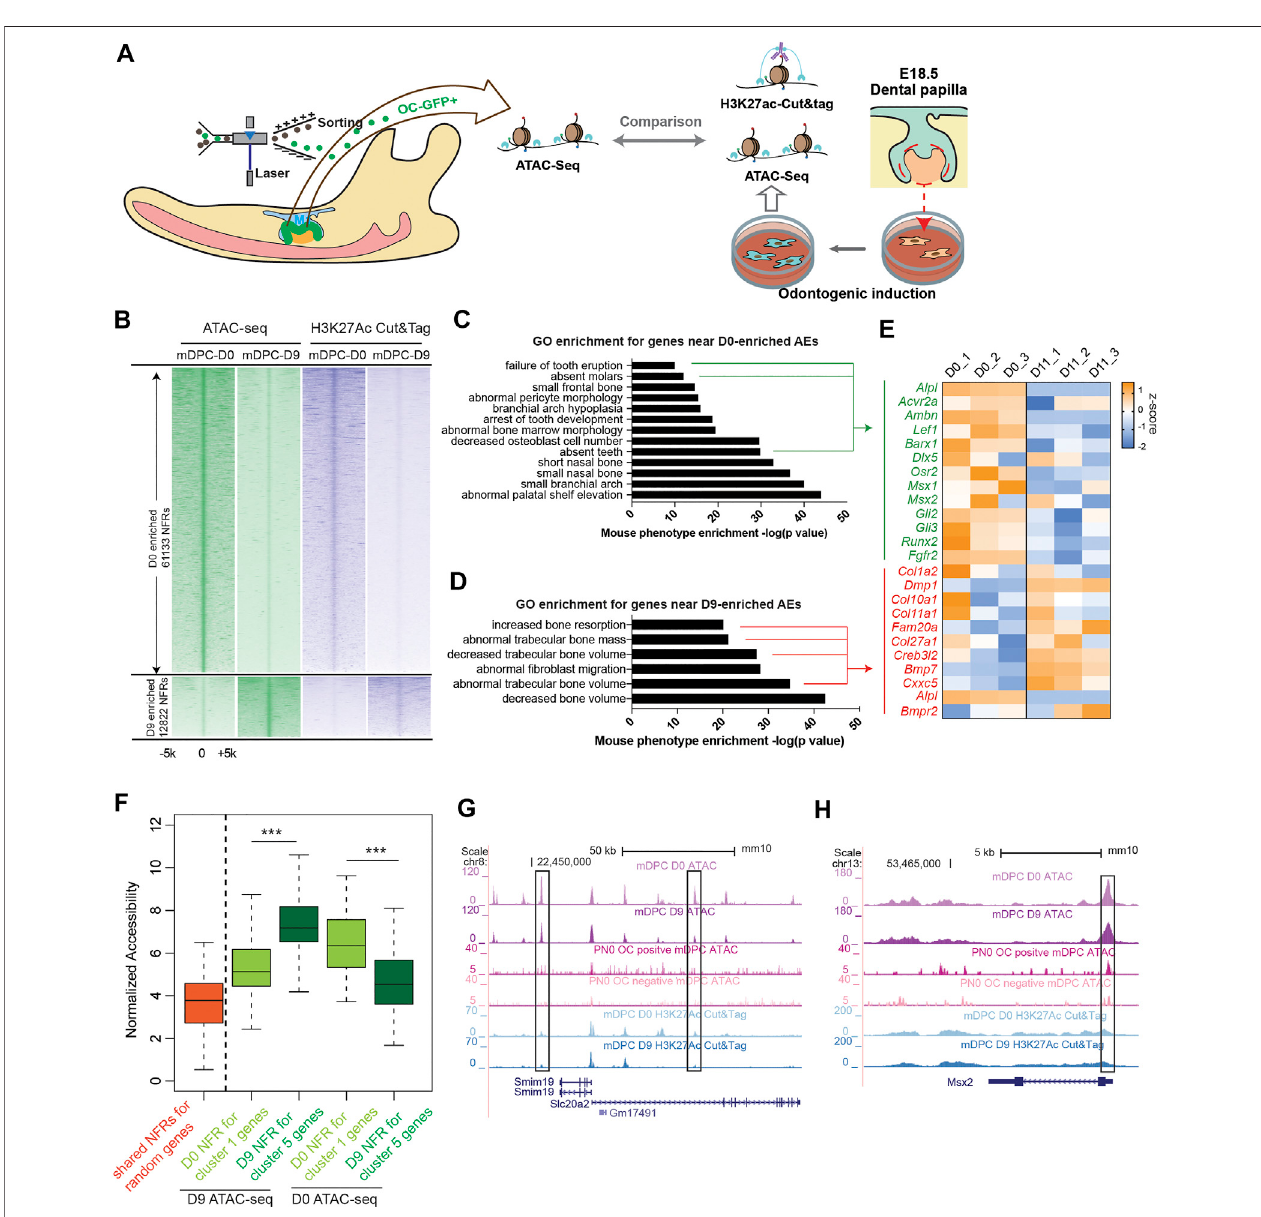
FIGURE 2 | Transposase-accessible chromatin assay with high-throughput sequencingATAC-seq) and H3K27Ac cleavage under targets and tagmentation (CUT and Tag) from both in vitro and in vivo odontoblast differentiation revealed chromatin early shaping predetermined dentinogenesis potential of dental papilla cells. (A) Study design comparing ATAC-seq from in vitro and in vivo odontoblast differentiation and annotation for active enhancers using H3K27Ac CUT and Tag. (B) Density plot of aligned ATAC-seq and H3K27Ac CUT and Tag peaks differentially enriched in D0 and D9 during mineralization of E18.5 dental papilla cells. Each line is centeredonthenucleosome-freeregion(NFR)withsigni fi cantlymorereadsinD0orD9ATAC-seq.ReadsinH3K27AcCUTandTagarealignedtothesameNFR.Gene ontology enrichment using “ Mouse Phenotype Single KO ” for D0- (C) and D9- (D) enriched active enhancers (AEs). (E) Expression changes of the overlapped genes from bulk RNA-seq pro fi le in indicated GO terms visualized in heatmap. (F) Plot of accessibility scores (generated in DiffBind) of elements with differential accessibility associatedwithgenesdifferentiallyexpressedincluster1andcluster5,showingelementswithincreasedaccessibilityinD9- in-vitro -differentiatedodontoblasttendtobe associated with genes enriched in cluster 5, and vice versa. *** p < 0.001, by Kolmogorov – Smirnov test. (G, H) UCSC genome browser view showing ATAC-seq and CUT and Tag peaks near the Slc20a2 and Msx2 loci.